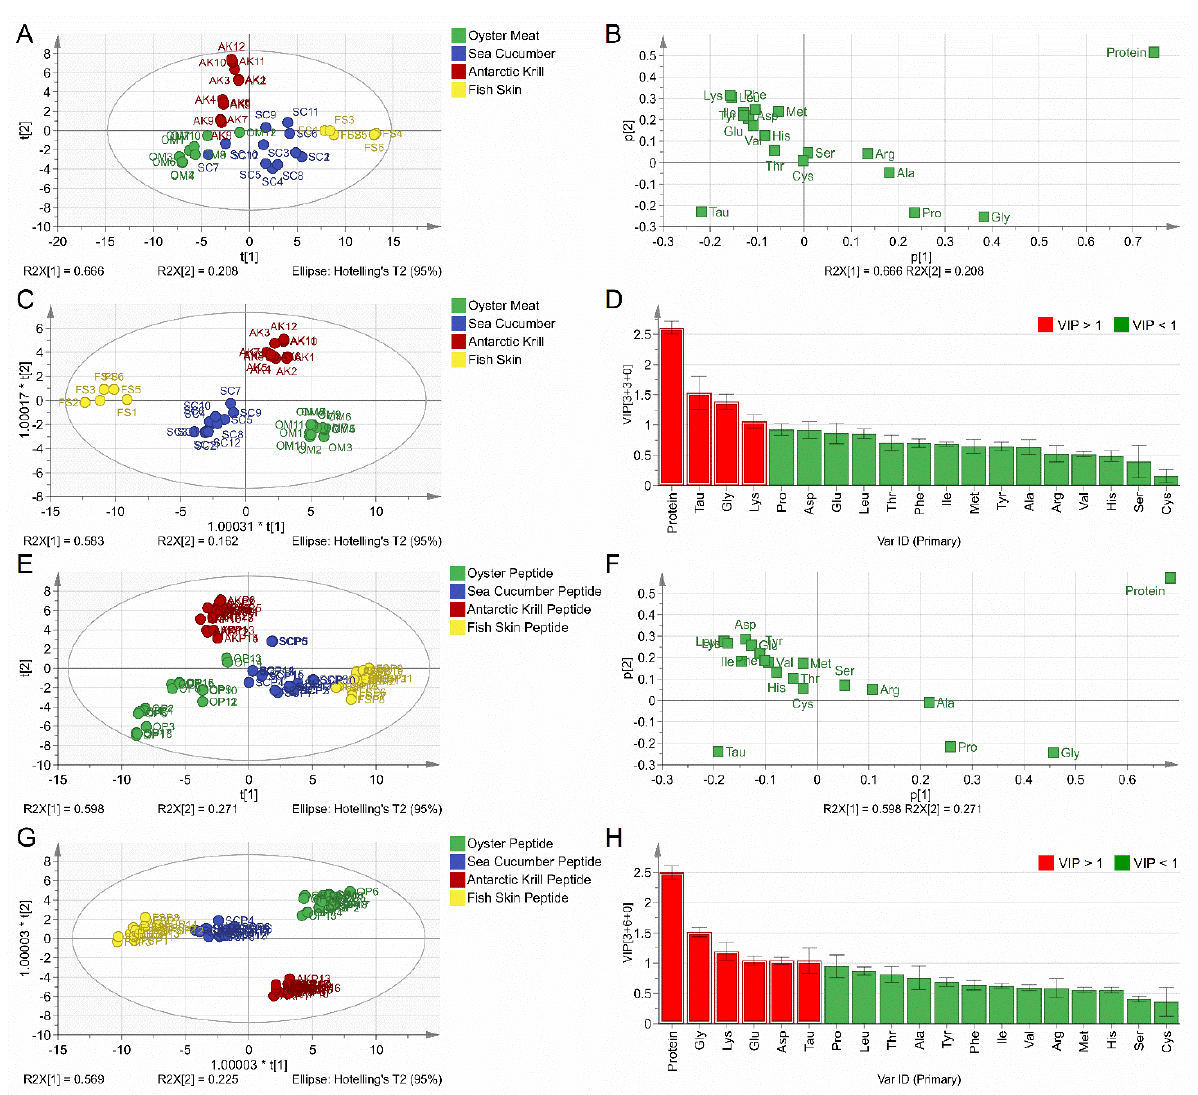
Figure 1. Chemometric analysis. ( A ) Score plot of the PCA for raw materials. ( B ) Loading plot of the PCA for raw materials. ( C ) Score plot of the OPLS–DA for raw materials. ( D ) VIP plot of the OPLS–DA for raw materials. ( E ) Score plot of the PCA for marine-derived peptides. ( F ) Loading plot of the PCA for marine-derived peptides. ( G ) Score plot of the OPLS–DA for marine-derived peptides. ( H ) VIP plot of the OPLS–DA for marine-derived peptides.